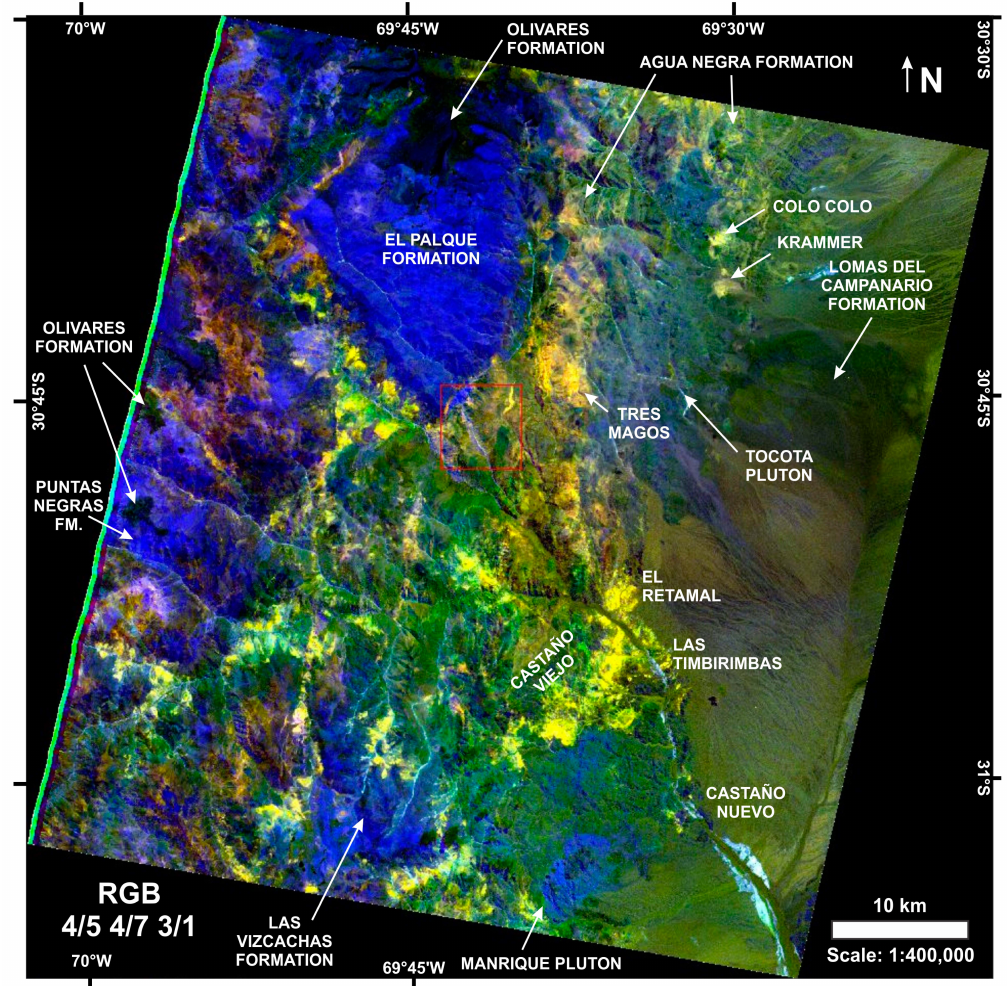
Figure 9. The enhanced ASTER band combination 4/5, 4/7, 3/1 with a linear stretch of 2% contrast was developed for the study area. Felsic units and silicified areas are shown in blue, whereas the phyllic and argillic alteration zones are highlighted in yellow. The intermediate volcanic to sub-volcanic rocks are shown in green, as are the Paleozoic and Mesozoic sedimentary units, whereas the basaltic lavas are dark green (cf. Figure